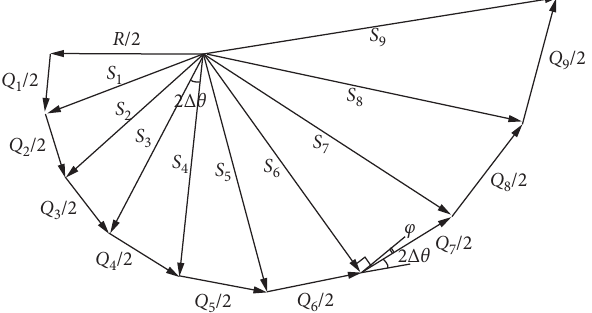
Figure 7: Stress superposition diagram of 9 stress columns.